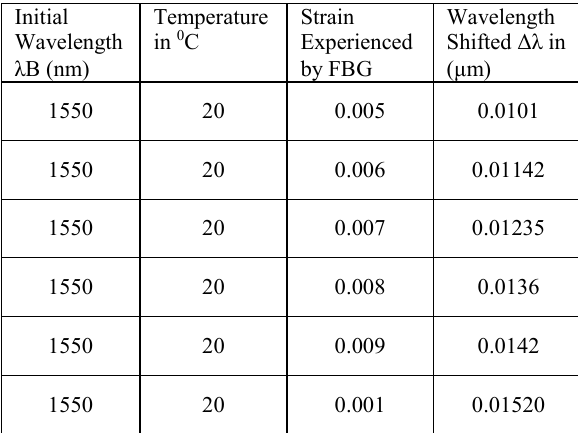
Table 3. Wavelength shifting (simulation